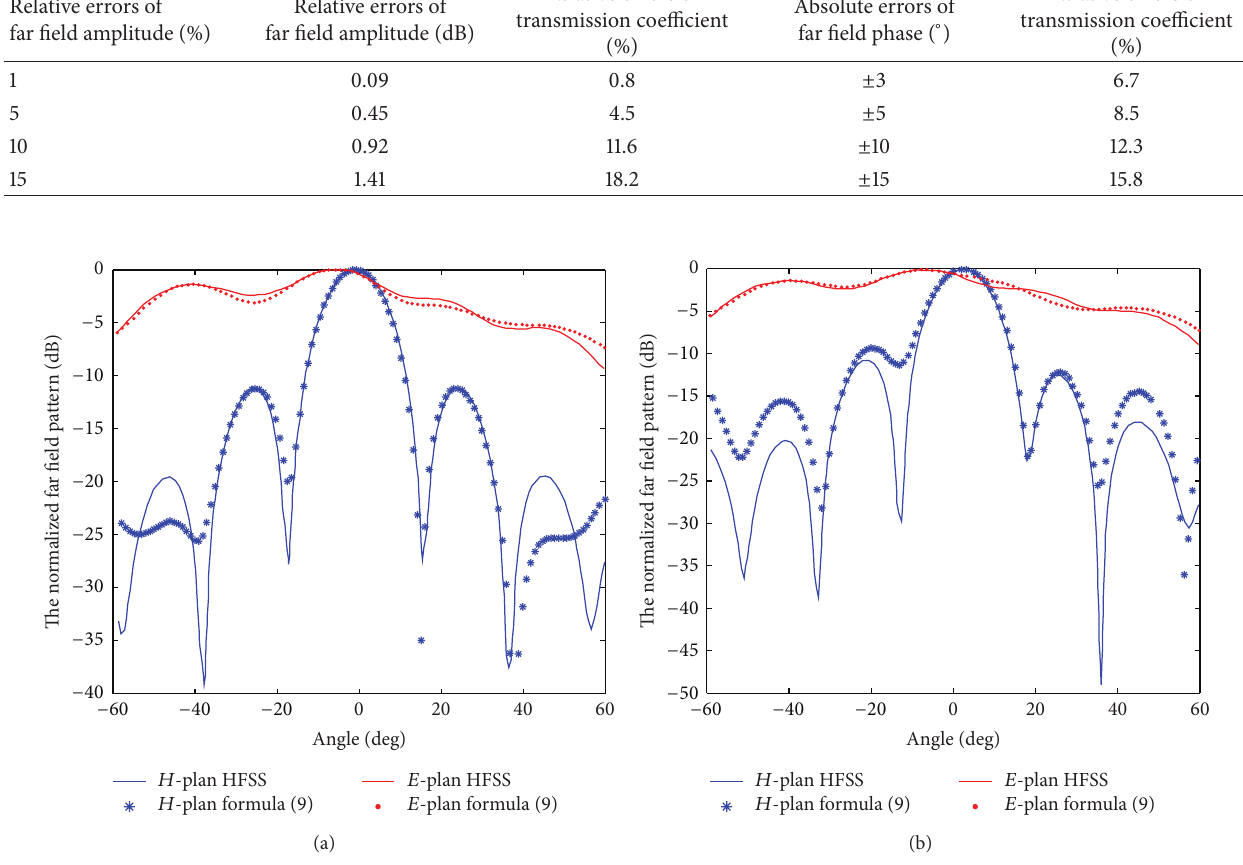
Figure 10: Comparison of far field pattern between HFSS and this formula (component 𝐹 𝑥